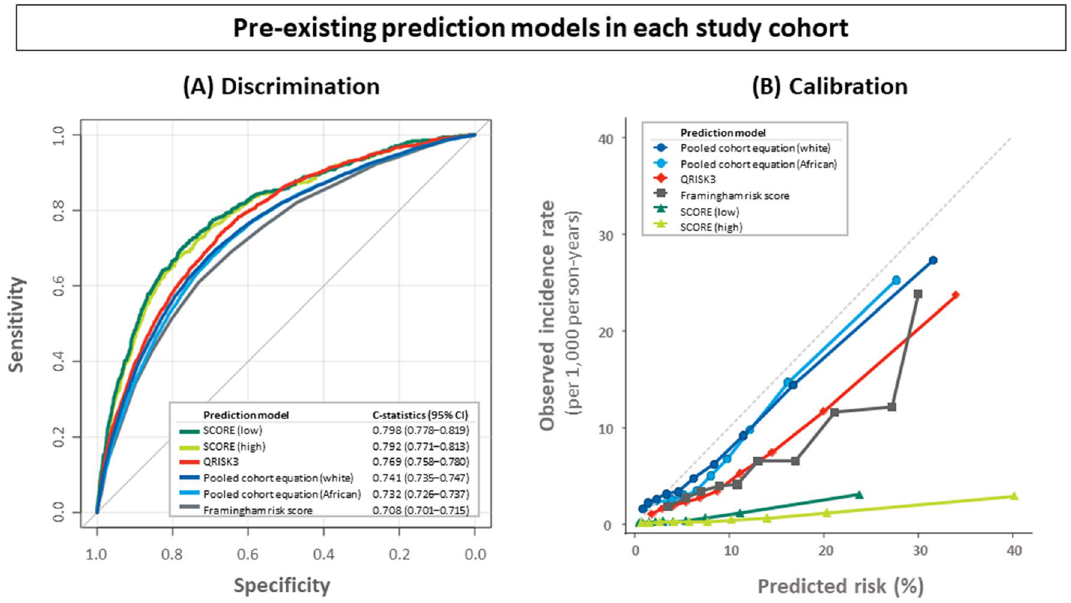
Figure 2. Discrimination and calibration of contemporary prediction models in each cohort. ( A ) Receiver operating characteristic curve analysis for contemporary prediction models. ( B ) Hosmer–Lemeshow calibration plots of contemporary risk prediction models. Risk score-specific predicted (x-axis) and observed events (y-axis) are depicted by deciles of calculated risk. SCORE (low) systematic coronary risk evaluation for low cardiovascular disease risk, SCORE (high) systematic coronary risk evaluation for high cardiovascular disease risk, pooled cohort equation (white) pooled cohort equation for whites, pooled cohort equation (African) pooled cohort equation for African Americans.